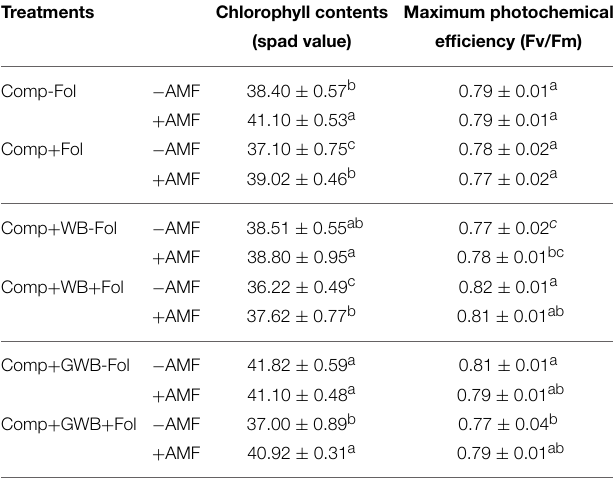
TABLE 3 | Effect of AMF and F. oxysporum f.sp. lycopersici on chlorophyll contents and photochemical efficiency of PSII of tomato plants grown in different soil substrate